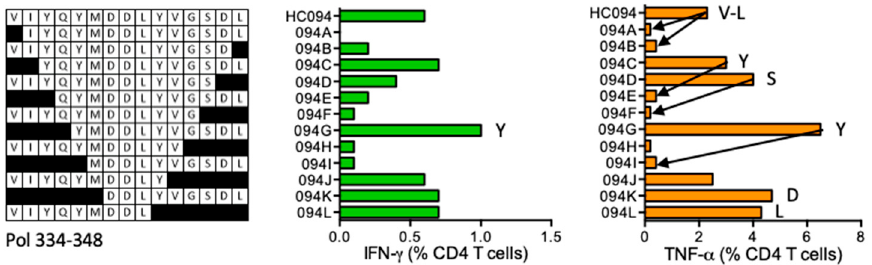
Figure 10. HC094 / VID 420—definition of CD4 + T-cell epitopes in HIV-1 protein Pol. HC094 peptide-grown SCTL from volunteer 420 was stimulated with truncated peptides (left) in an ICS assay and production of IFN- γ (green) and TNF- α (orange) by CD4 + T cells was monitored. Arrows in the graph and amino acids V, L, Y, S and D indicate the stimulatory peptide termini.